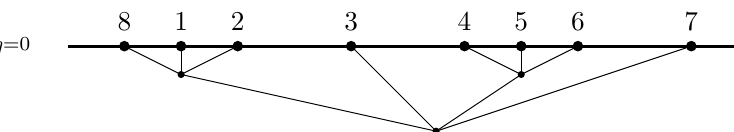
Figure 12 . Eight-point Witten digram corresponding to the ladder graph, A ( I 8 : 15 , 28 , 37 , 46) . we can finally show